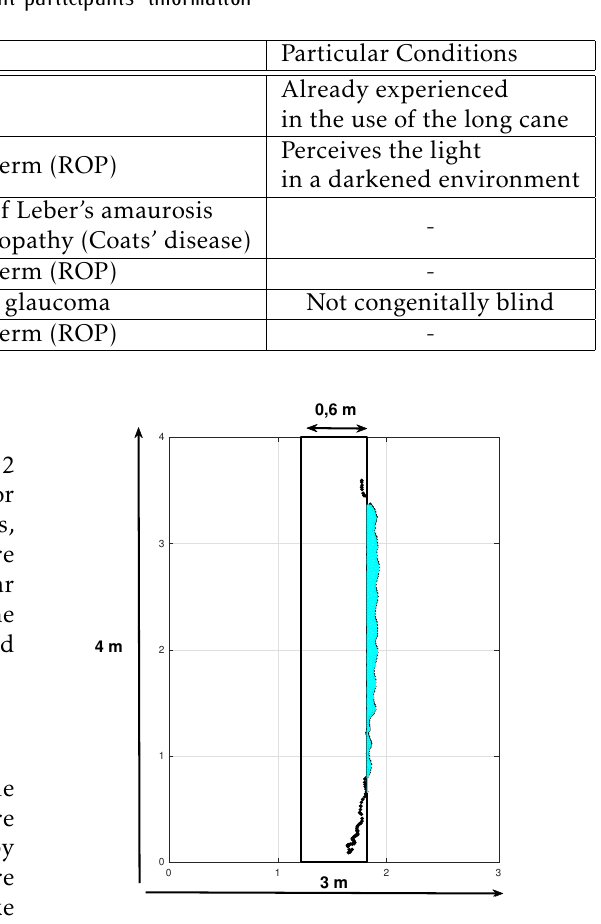
Figure 2. Participant C pre-test. An example of veering